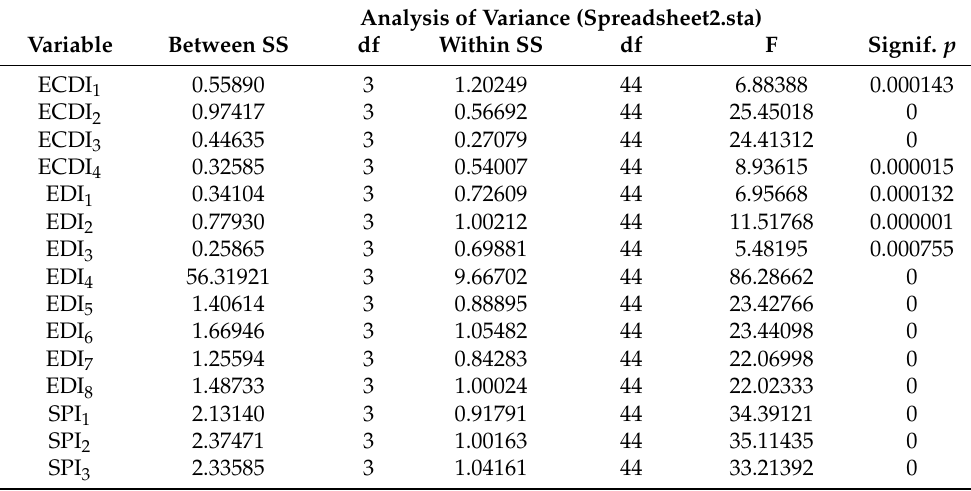
Table 8. Countries clustered into four groups based on variance analysis